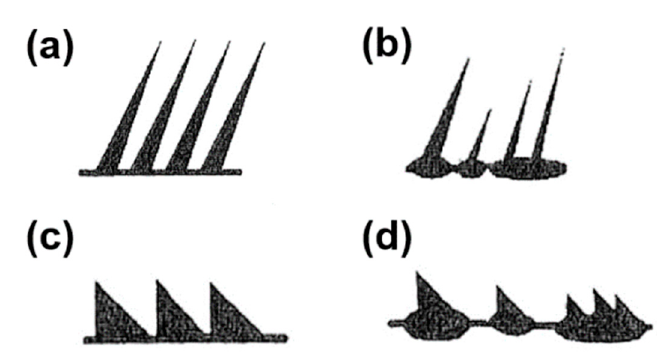
Figure 1. Classification of Widmanstätten ferrite. ( a ) Primary Widmanstätten sideplates, ( b ) Secondary Widmanstätten sideplates, ( c ) Primary Widmanstätten sawteeth, ( d ) Secondary Widmanstätten sawteeth.